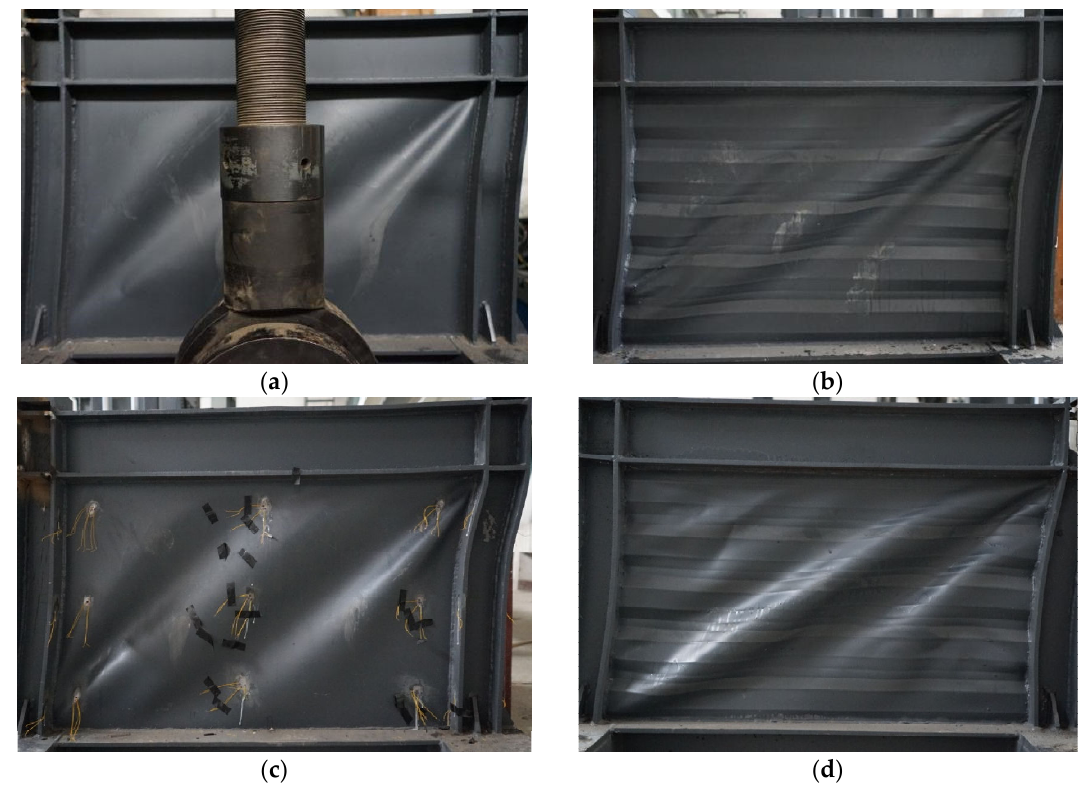
Figure 4. Failure mode of specimens ( a ) A, ( b ) B, ( c ) C, and ( d ) D. Taking specimen A (the SPSW with flat panel) as an example, the buckling of the flat panel did not occur when the top displacement was 4 mm. The tension field strips may be formed, which were inclined, and the inclination angle of the strips was about 45 ◦ , as shown in Figure 4a. When the lateral load reached 300 kN for the first time, the specimen produced a loud bang. In the following cycles, the specimen would continue to make loud bangs. As the top displacement increased, the infill steel plate gradually began to yield. At the end of each cycle, the specimen had a large residual deformation. With the increase in loading cycle number, the residual deformation increased. There were no cracks formed during the whole test. The ultimate deformation of the flat SPSW was large than 62 mm, whereas the shear bearing capacity of the flat SPSW was reduced by about 15%. When the test finished, local buckling may be formed in the flange of the compression column, and there was only a slight out-of-plane deformation formed in the flat SPSW.